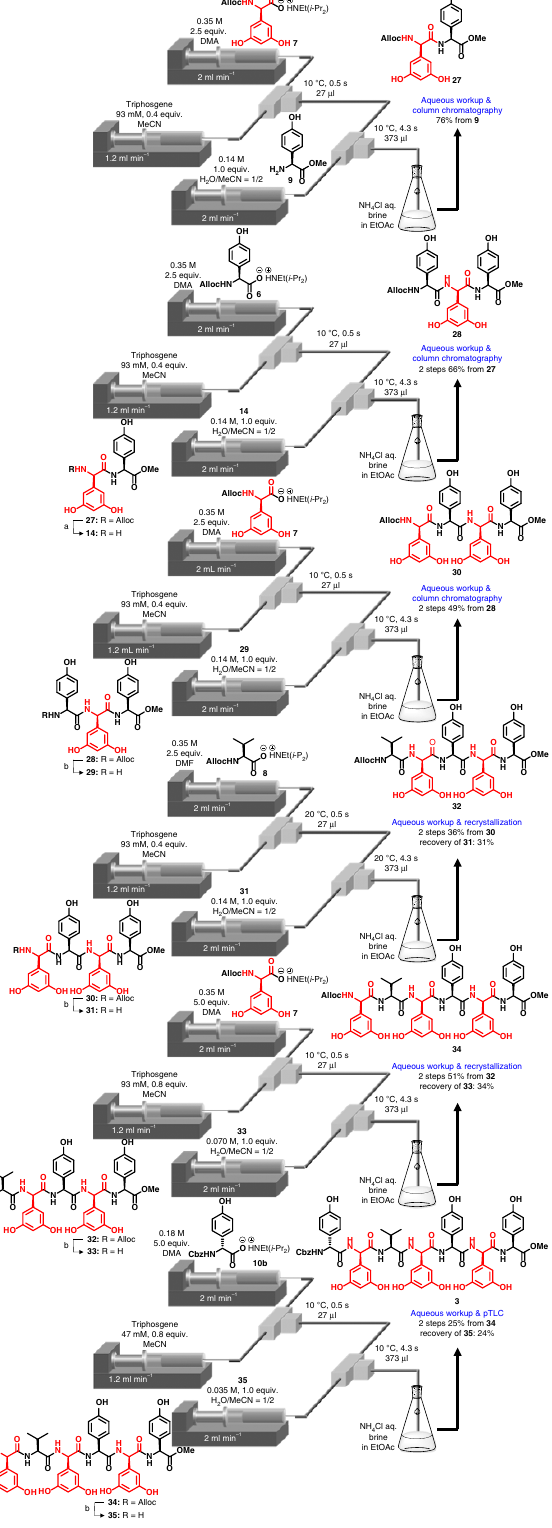
Figure 4 | Synthesis of N-terminal heptapeptide 3 using micro-flow amidation. Conditions: ( a ) Pd(PPh 3 ) 4 , PhSiH 3 , CH 2 Cl 2 /MeOH/H 2 O, r.t., 40min, batch. ( b ) PS-Ph 3 P-Pd, PhSiH 3 , CH 2 Cl 2 /MeOH/H 2 O, r.t., 1.5–2.5h,